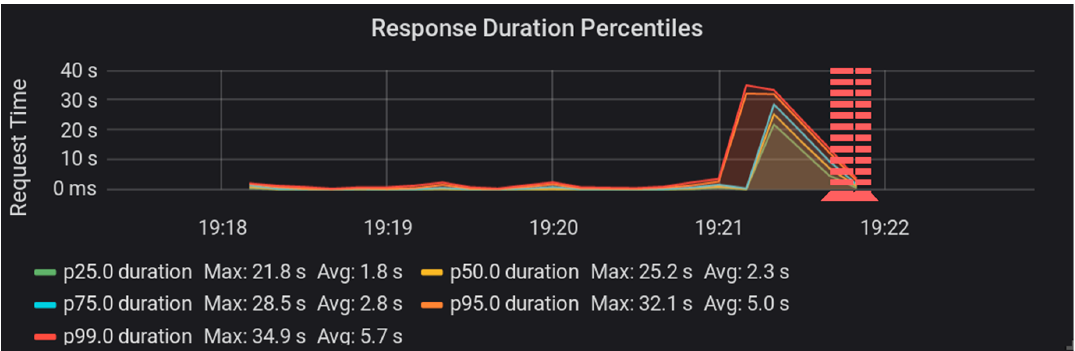
Figure 7. Trellis PostgreSQL performance degrades at 320 requests per second.